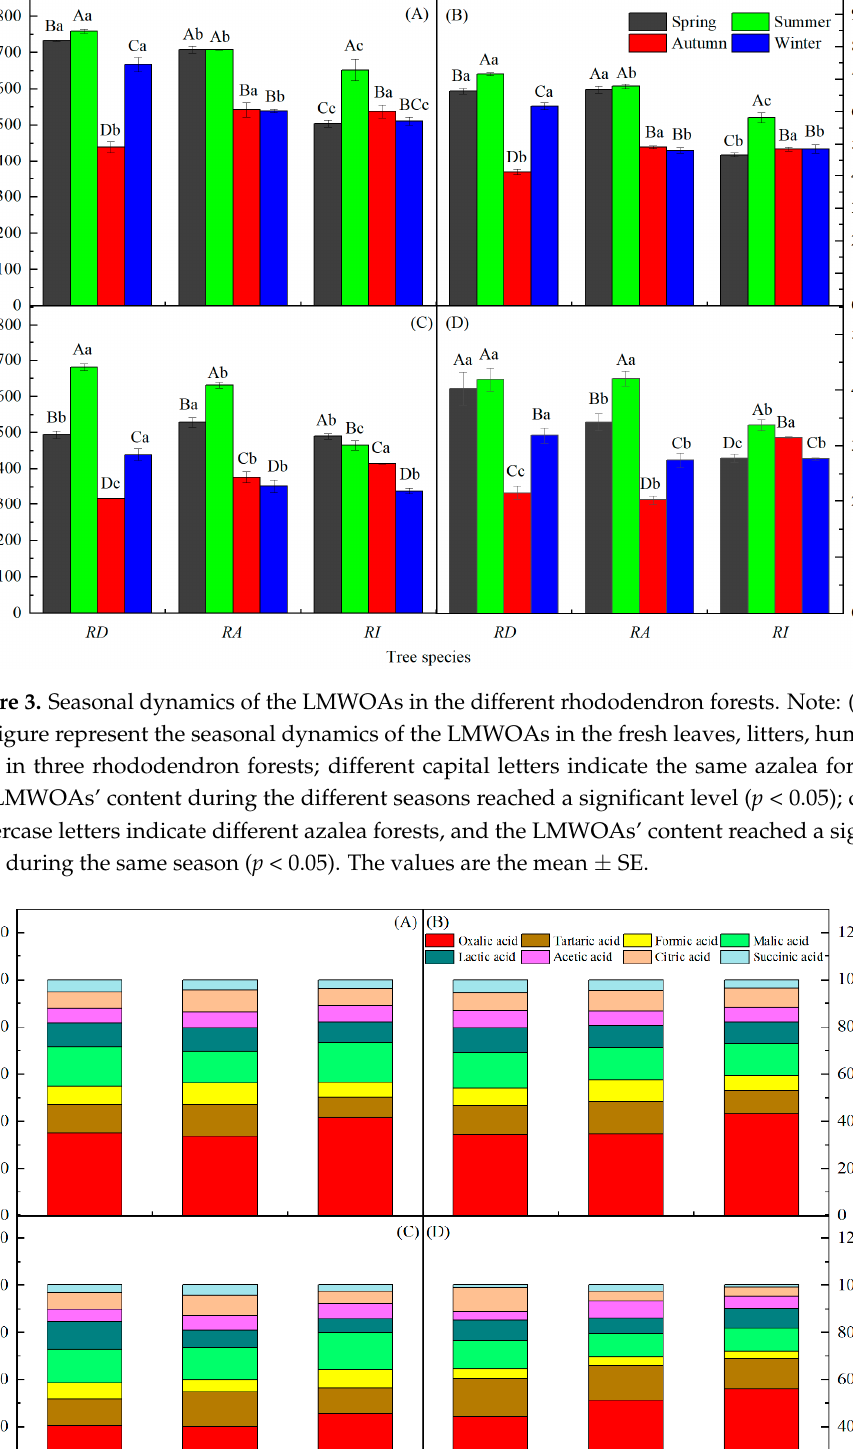
Figure 5. The total LMWOAs’ content in the different rhododendron forests. Note: Different capital letters represent significant content differences between different sampling positions of the same rhododendron ( p < 0.05); different lowercase letters indicate that the LMWOAs’ content between the same sampling position in the different rhododendron forests was significant ( p < 0.05). The values are the mean ± SE. The Spearman correlation between the soil parameters and the LMWOAs showed that the two indexes had obvious correlations (Figure 6). Among them, the pH value and the SOC were significantly positively correlated with acetic acid and significantly nega- tively correlated with lactic acid ( p < 0.05). The humidity was significantly positively cor- related with tartaric acid, formic acid, and malic acid, and it was significantly negatively correlated with oxalic acid ( p < 0.05). The TN, HN, and TP were significantly positively correlated with oxalic acid, and they were significantly negatively correlated with tartaric